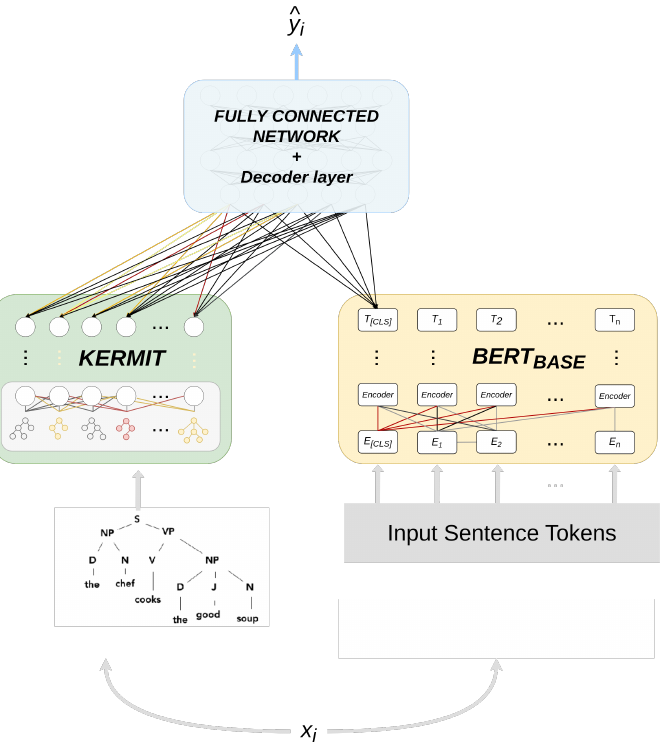
Figure 1. Proposed architecture formed by the modules of BERT and